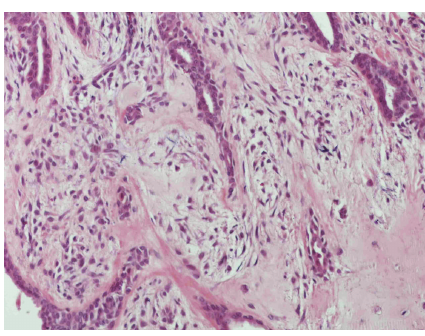
Figure 7: Myxoid mesenchymal matrix.